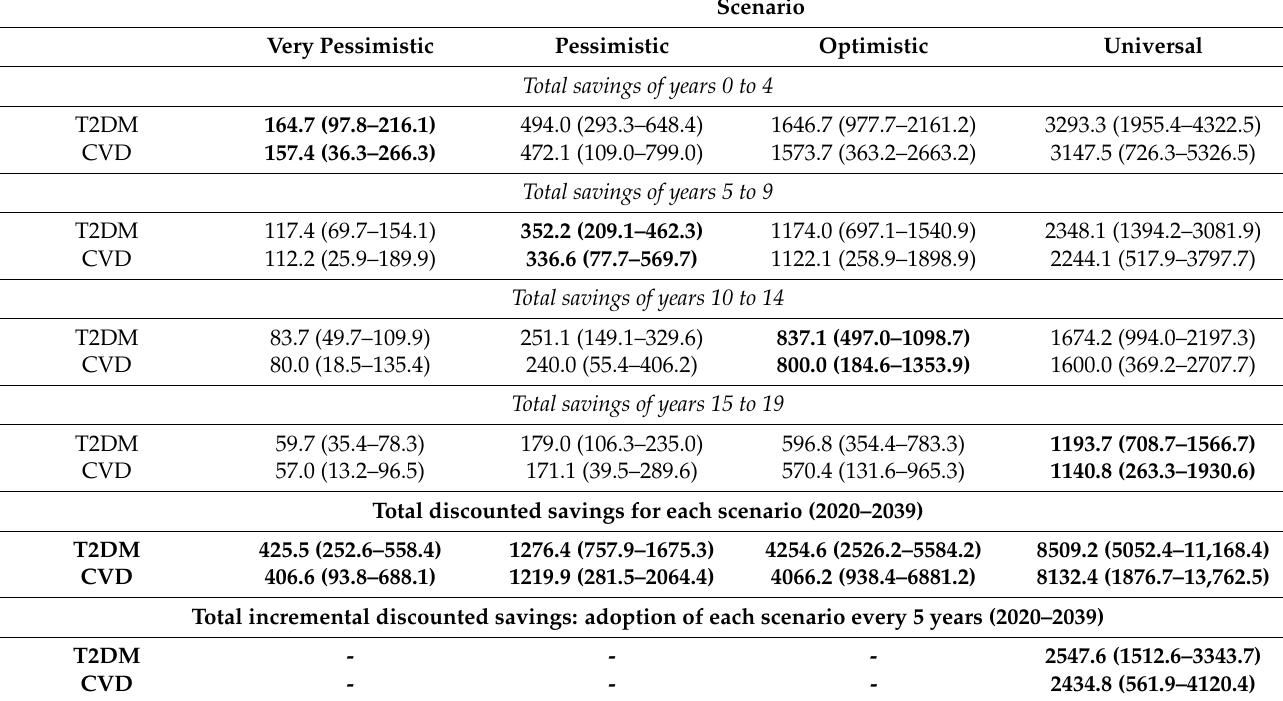
Table 5. Sum of potential total discounted savings on direct health and productivity loss expenditures of Type 2 Diabetes Mellitus and cardiovascular disease in Australian adults (age 20 and over) from whole grain intakes over short-term and long-term periods (AUD million) 1